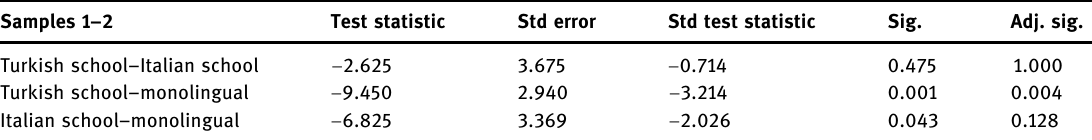
Table 3: Case summary: each row tests the null hypothesis, that is, the distribution of samples 1 and 2 is the same. The asymptotic signi fi cance ( two - sided tests ) is displayed. The signi fi cance level is set at 0.05 Samples 1 – 2 Test statistic Std error Std test statistic Sig. Adj. sig.